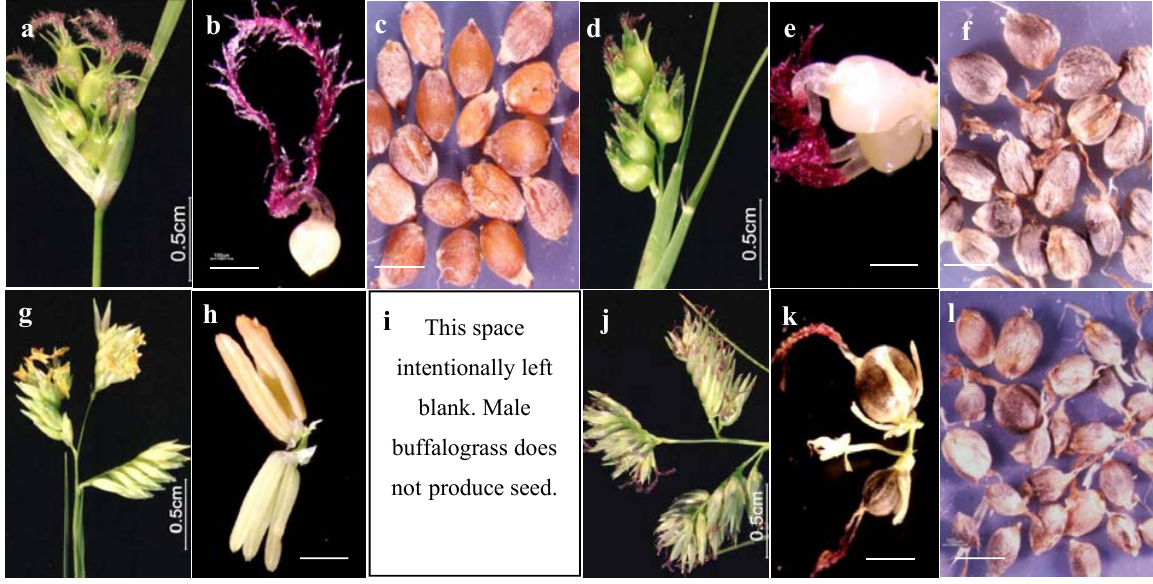
Figure 3. Developmental changes in inflorescence architecture and ovary development for buffalograss infected by the pistil smut fungus. ( a ) inflorescence of uninfected female buffalograss. ( b ) a spikelet of uninfected female buffalograss contains a single pistil (pictured) with fully developed stigmas, style, and ovary. ( c ) seed (caryopses) produced by uninfected female buffalograss. ( d ) inflorescence of infected female buffalograss. ( e ) a spikelet of infected female buffalograss contains two pistils (pictured) each with fully developed stigmas, style, ovary, and hypertrophied stamens. ( f ) smut balls, not seed, are formed in florets of infected female as ovaries become filled with fungal teliospores. ( g ) inflorescence of uninfected male buffalograss. ( h ) a spikelet of uninfected male buffalograss contains two stamens (pictured) each with fully developed anthers and filaments. ( i ) this space was intentionally left blank as no seed is produced by uninfected male buffalograss. ( j ) inflorescence of infected male buffalograss displays the presence of purple feathery stigmas. ( k ) a spikelet of infected male buffalograss contains three pistils (pictured) each with fully developed (or developing) stigmas, style, ovary, and underdeveloped stamens. ( l ) smut balls form in florets of infected male buffalograss as induced ovaries become filled with fungal teliospores. Bar = 0.25mm unless otherwise